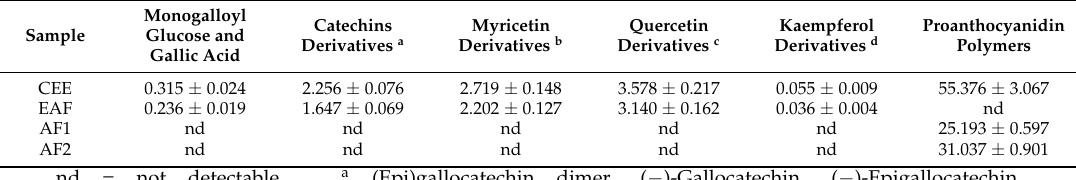
Table 2. Mean concentration of phenylpropanoids ( µ mol/mL) in CEE and enriched fractions of Cistus incanus leaves ( n = 3).